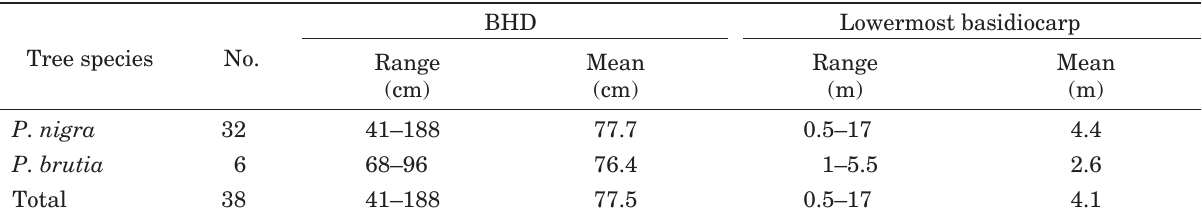
Table 1. Range and mean values of the breast height diameter (BHD) of the Pimus nigra and P. brutia with basidio- carps of Porodaedalea pini, and the height above ground of the lowermost basidiocarp.